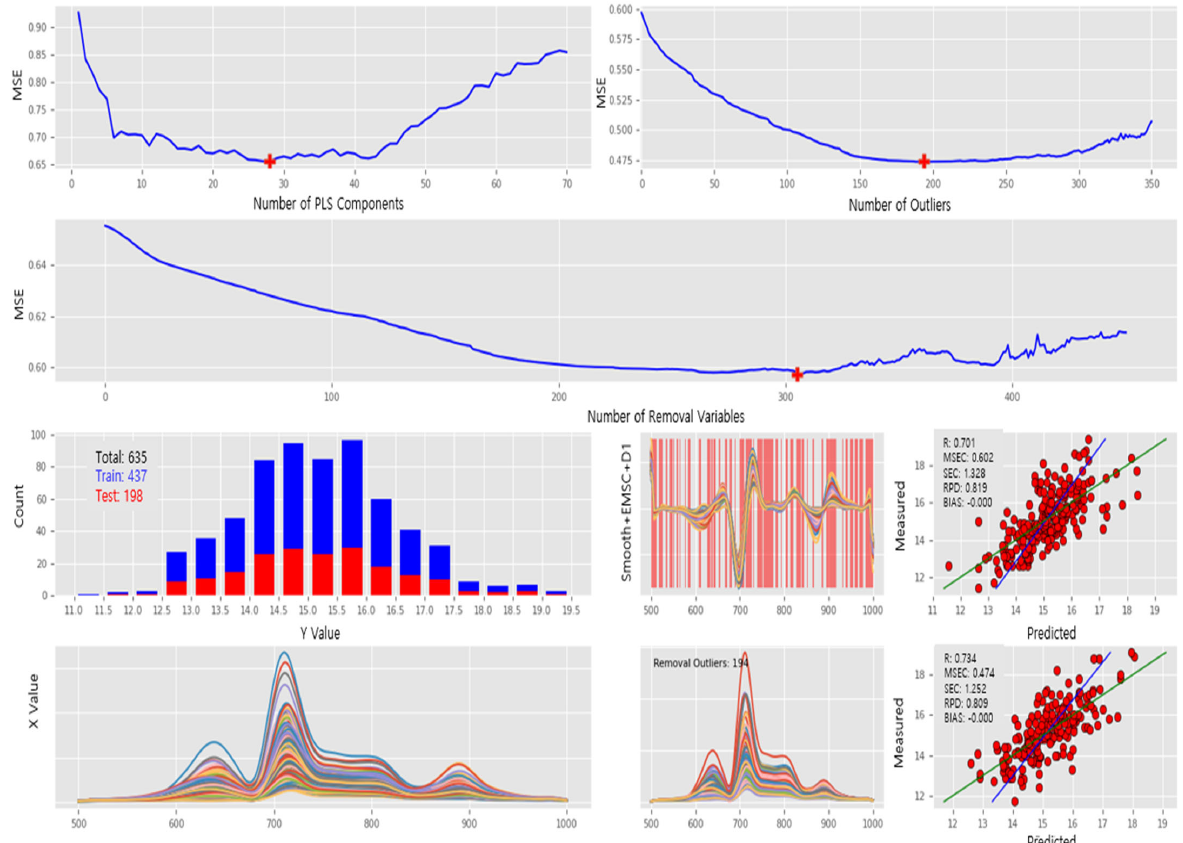
Figure 7. Preprocessing, data splitting, calibration, and validation of PLS model for spectra captured under VIS + NIR LED module: (1st and 2nd rows) MSE plots along with the number of PLS components, removal outliers, and removal wavelengths as x ‐ axis in clockwise direction. (3rd row) Sample distribution for PLS calibration and validation, preprocessed spectral intensity, and PLS calibration report. (4th row) Raw spectral intensity, removed outliers during PLS calibration, and PLS validation report. Table 1. R, MSE, Std. of Error, RPD, and Bias for PLS calibration, and validation of Fuji apple SSC prediction under TH lamp, and the VIS + NIR LED module.